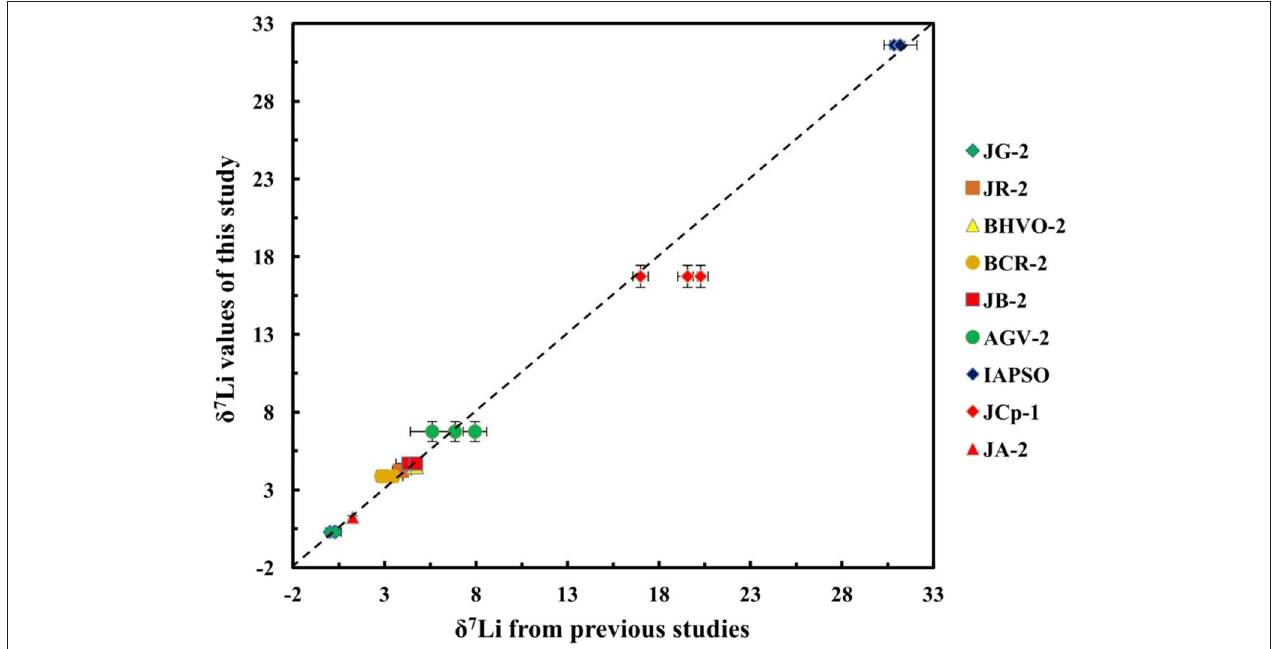
FIGURE 12 | Lithium isotope compositions of geological standard